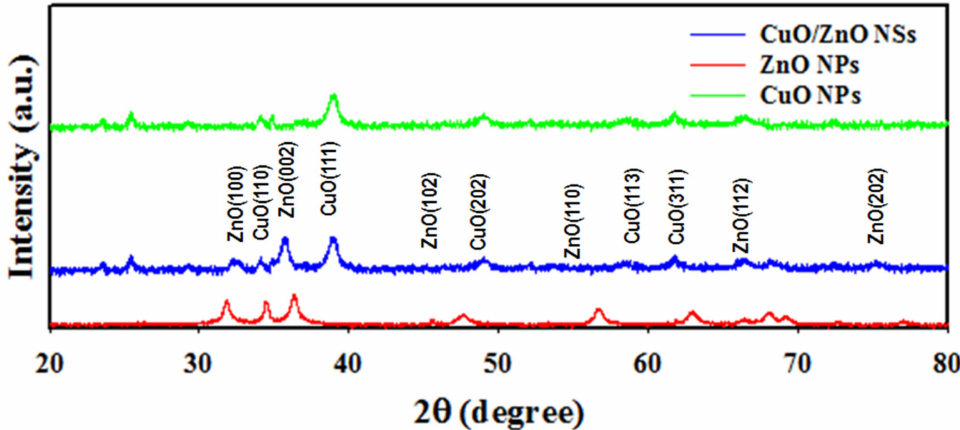
Figure 3. The powder X-ray diffraction analysis of CuO/ZnO